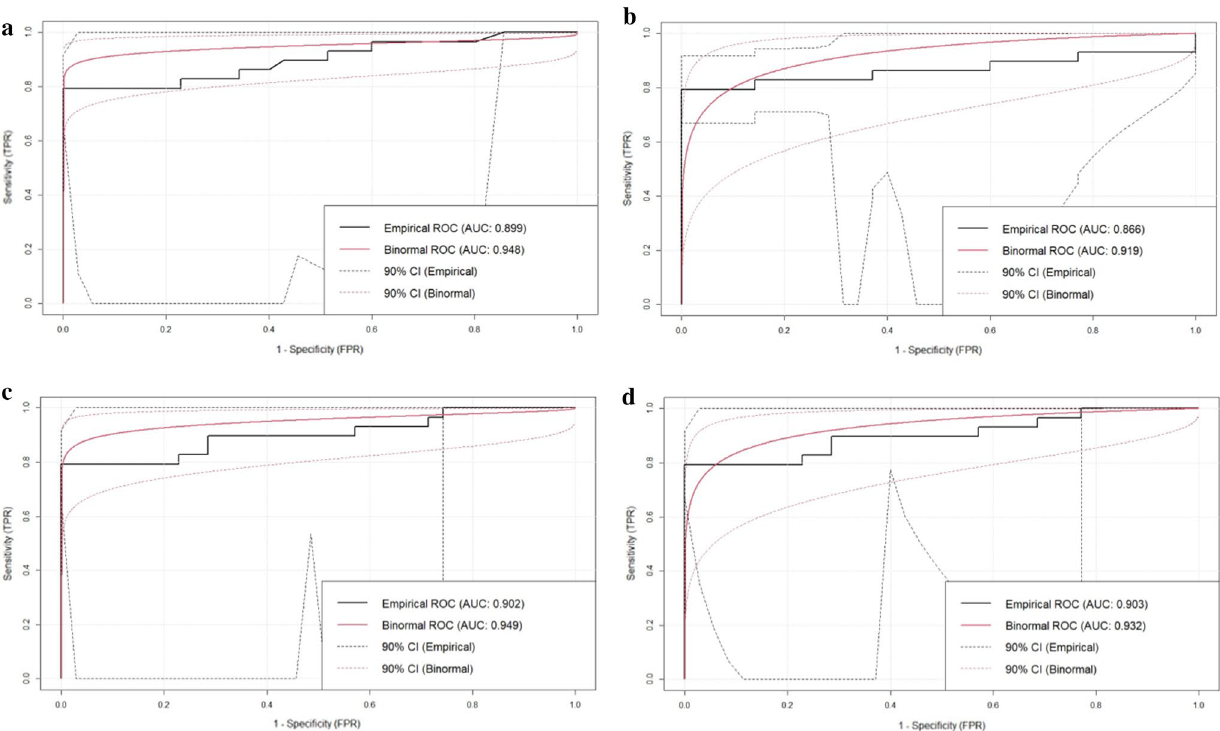
Fig. 10 Validation of novel hybrid models, such as a AND, b OR, c GAMMA 0.8, and d GAMMA 0.9 using empirical and binormal ROC